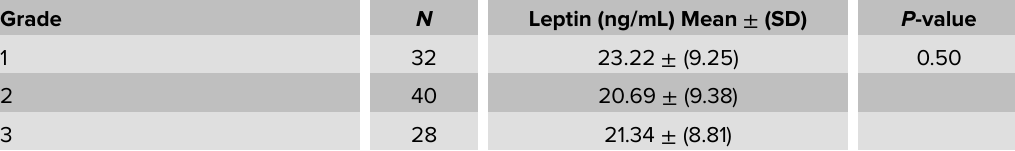
Table 4: Mean values of leptin concentration in different grades of